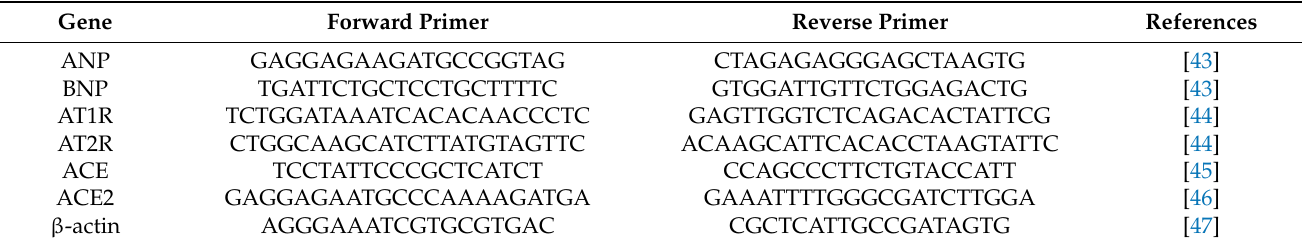
Table 1. Nucleotide sequences of primers used in real-time